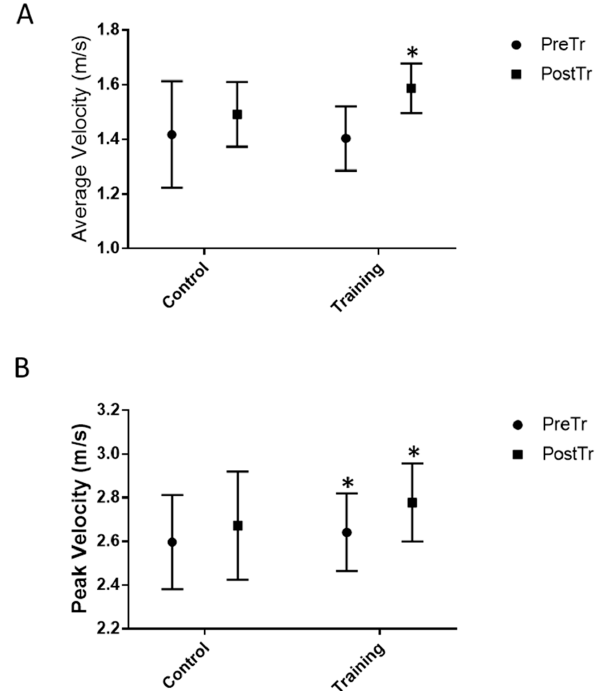
Figure 4. Functional test measures: ( A ) average velocity (m/s) and ( B ) peak velocity (m/s) before and after 8 weeks of plyometric jump training or rest. Peak values represent the highest of the three test jumps. * p < 0.005.